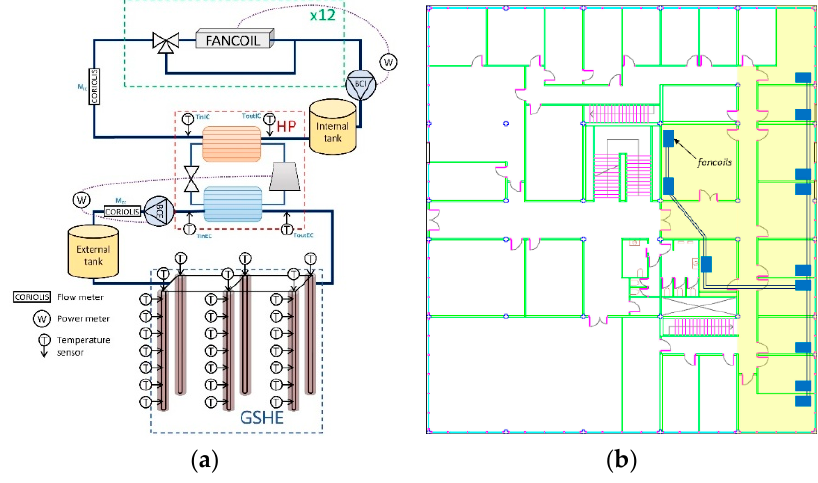
Figure 1. GSHP installation at UPV: ( a ) schematic diagram; and ( b ) fancoils distribution in the building.